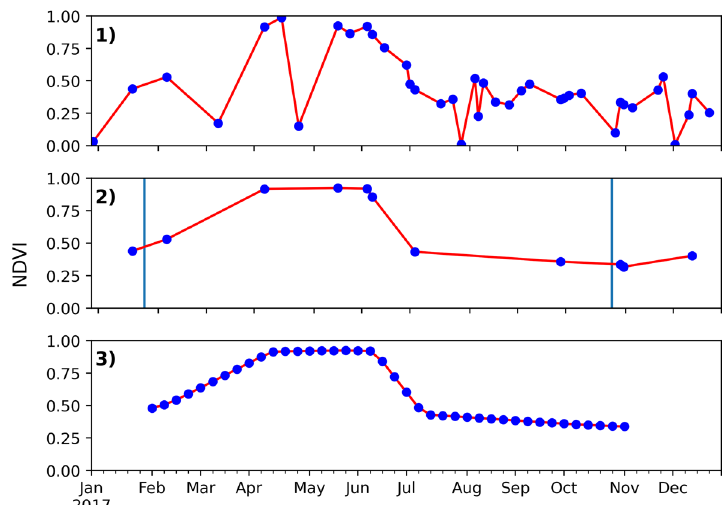
Fig. 2 Preprocessing workflow: (1) input time series (2) cloudy dates removed (middle) (3) final time series (cropped and resampled)